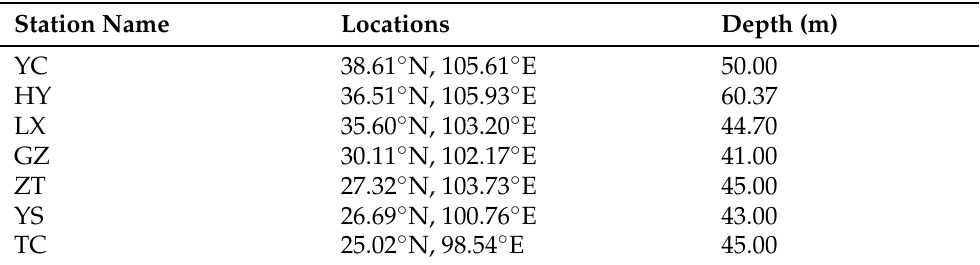
Table 1. Specifications of borehole strain stations used in this